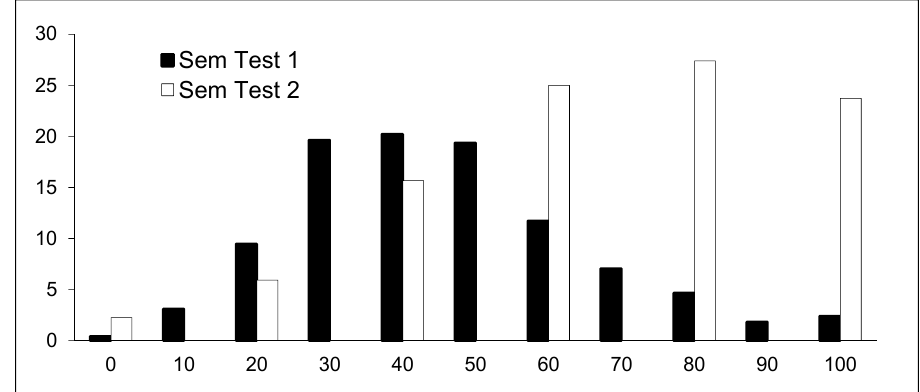
Figure 5 : Performance in graphical interpretation in Semester Tests 1 and